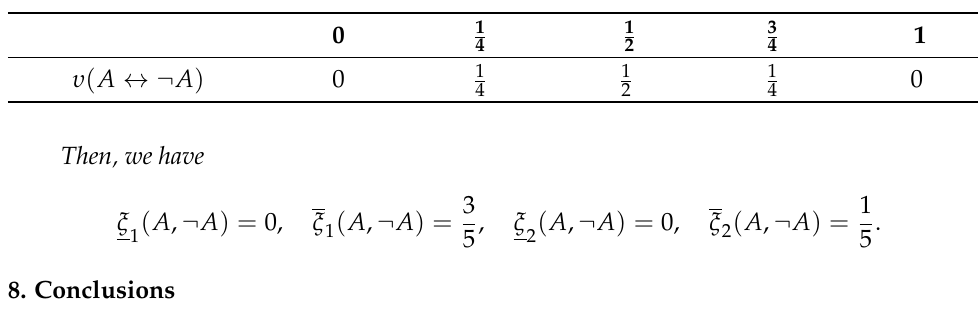
Table 8. All valuation of formula A ↔ ¬ A